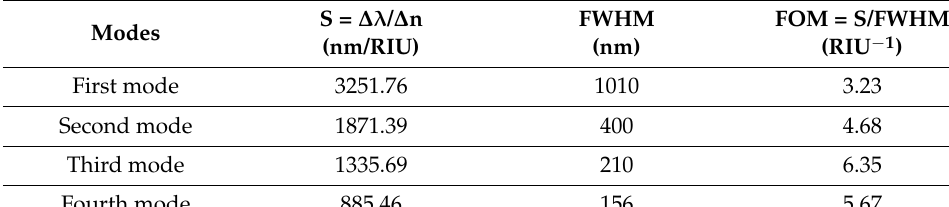
Table 1. Comparison of the values of refractive index sensitivity (S), full width at half maximum (FWHM) and figure of merit (FOM) of the four plasmonic modes.